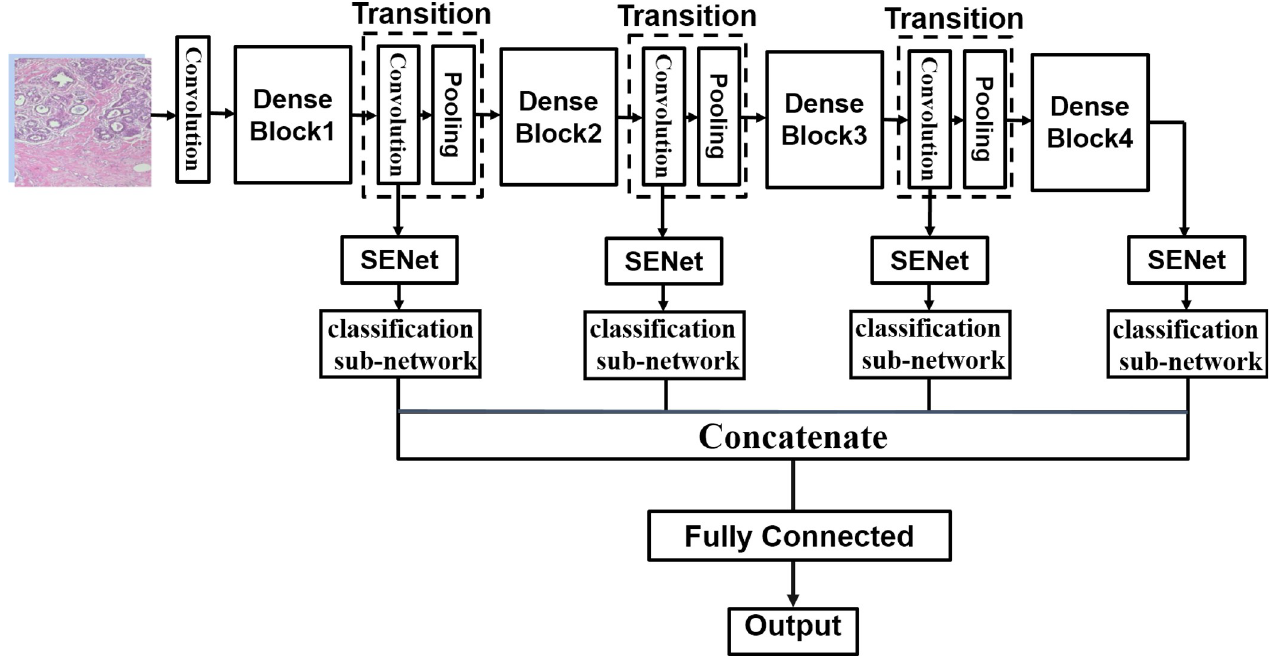
Fig 2. Overview of the proposed IDSNet